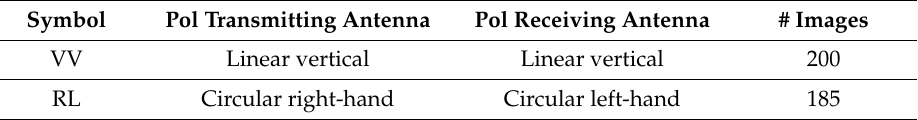
Table 6. Configurations of the long time measurements.